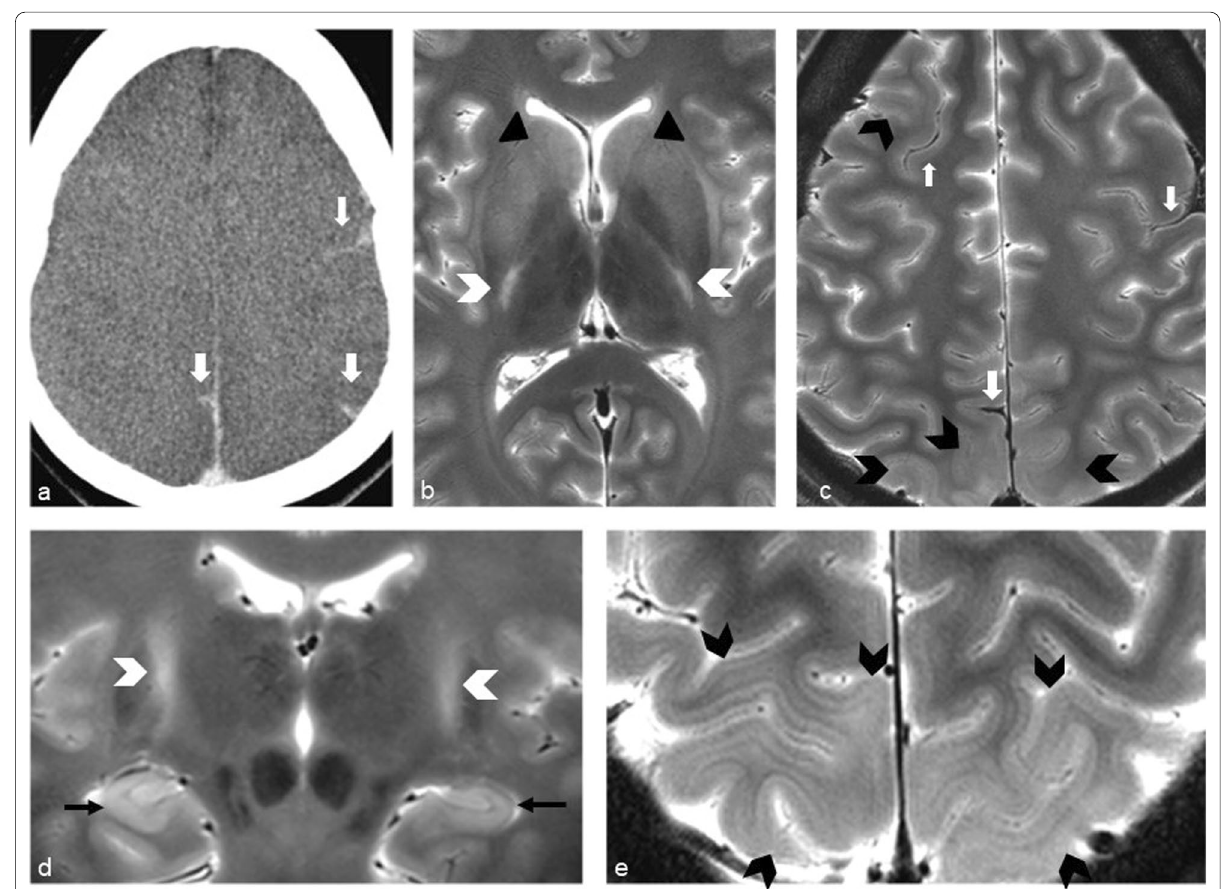
Fig. 3 Patient 2. Bilateral subarachnoid hemorrhages (white arrows) in frontal and parietal sulci on CT ( a ) and axial T2 ( c ), signal abnormalities in the corticospinal tracts (white arrowheads b , d ), bilateral basal ganglia ( b —black arrowheads), hippocampi ( d —black arrows), bilateral cortical/ subcortical parietal lobes, and more subtle in the right frontal lobe ( c , e —black